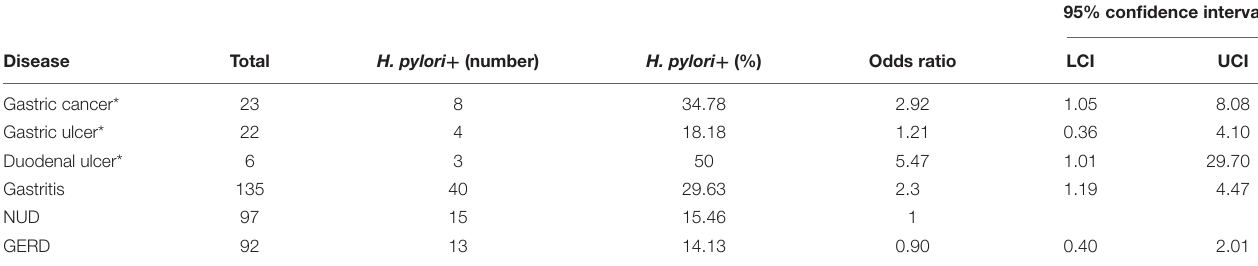
TABLE 1 | The incidence of different upper GI diseases and the prevalence of H. pylori infection within the study group ( N = 375).